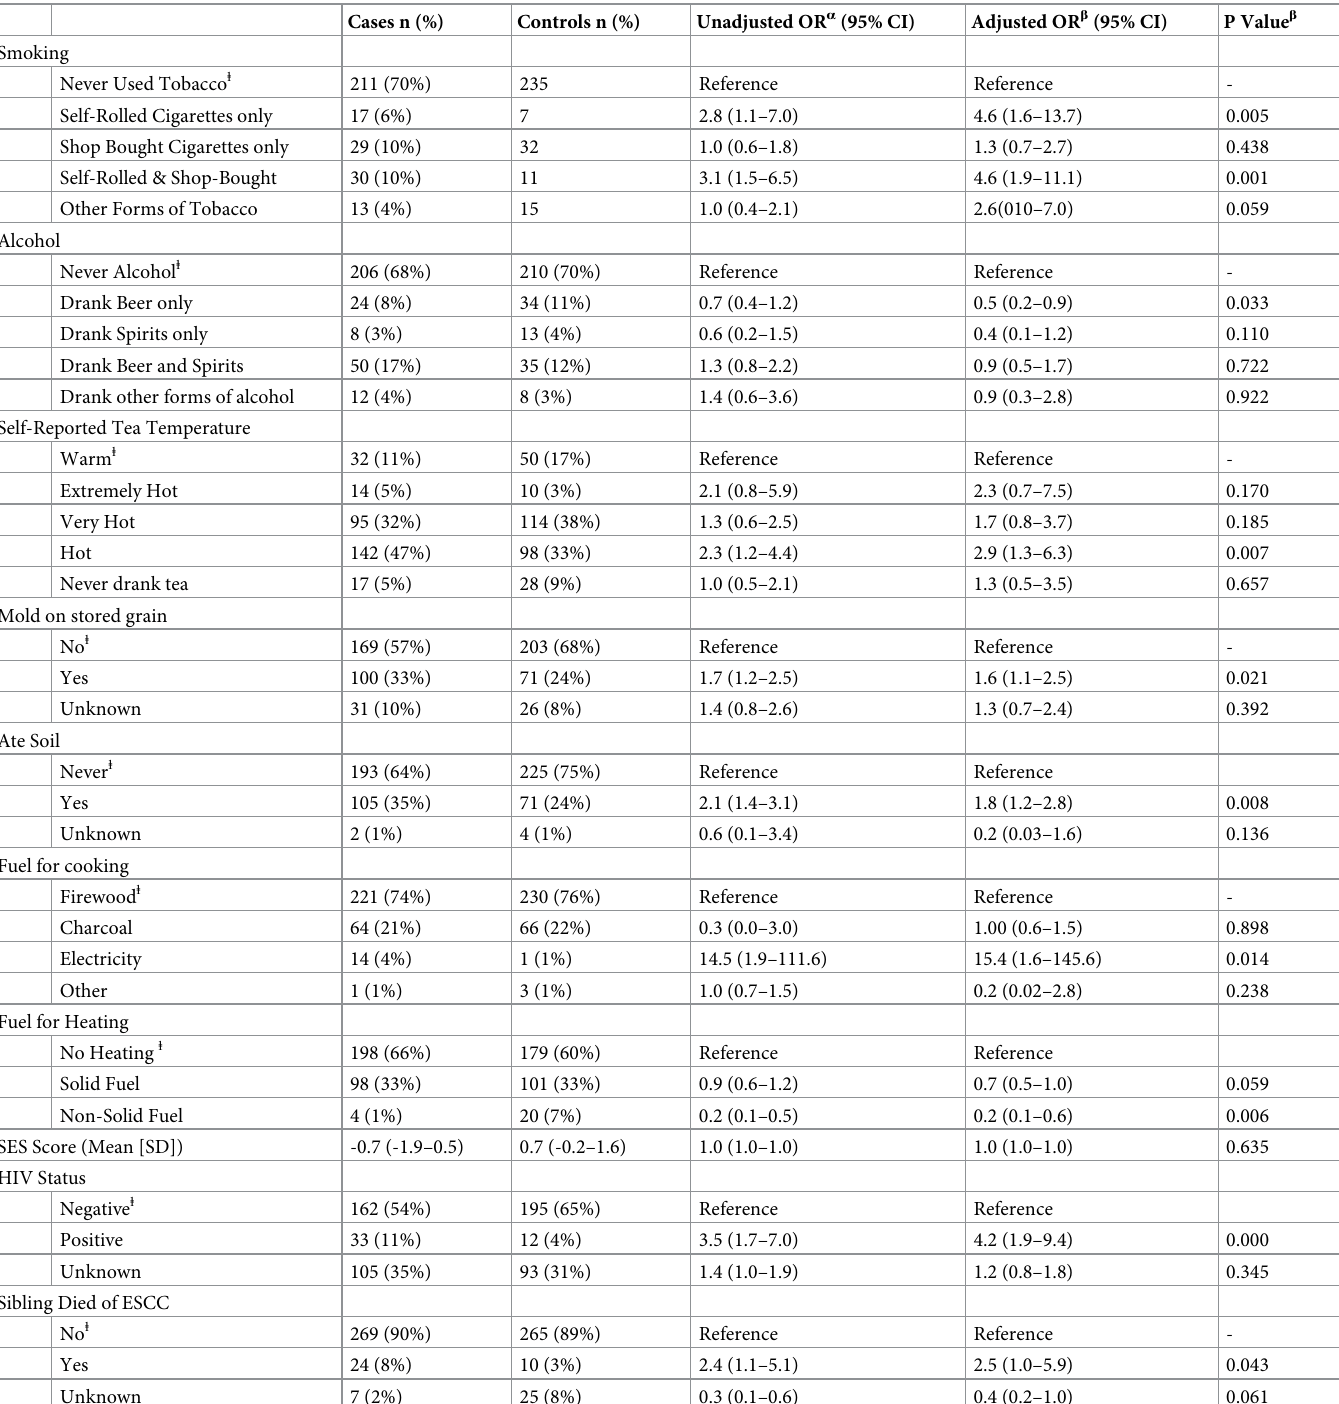
Table 2. Adjusted odds for ESCC for selected risk factors among participants enrolled in an ESCC case-control study in Lilongwe,